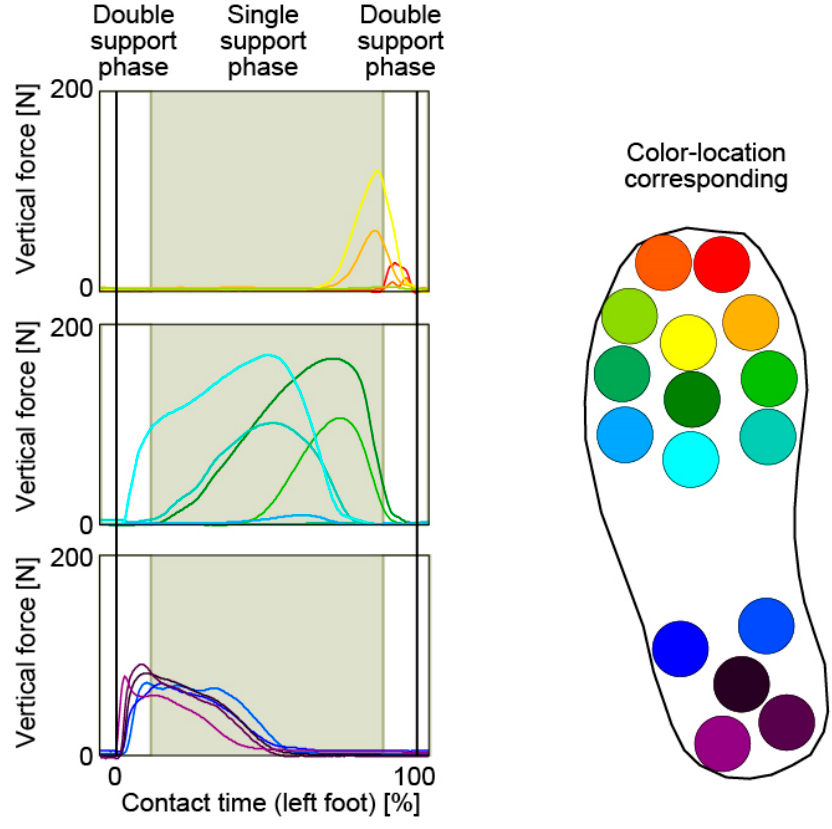
Figure 4. Change of vertical forces during the contact phase of the left foot.